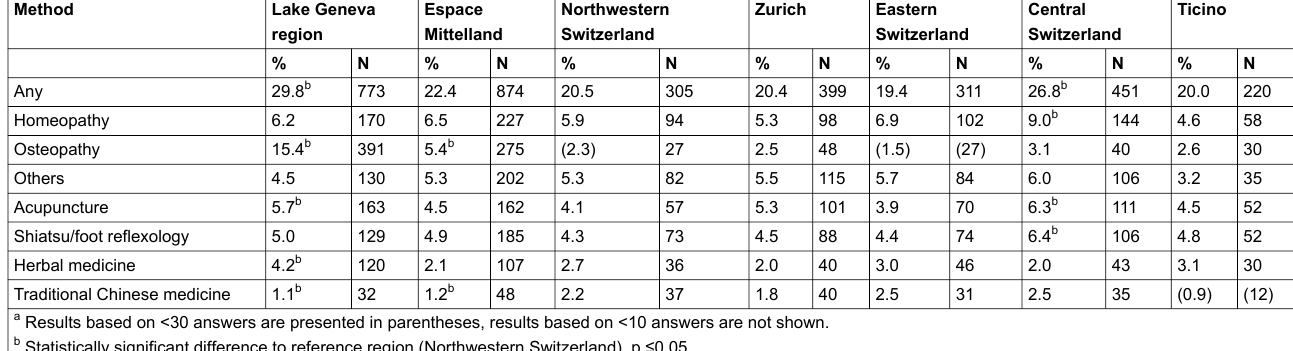
Table 1: Usage of various methods of CM (percentage and number of respondents [N]) in the last 12 months depending on area of living (Swiss Health Survey, Switzerland, 2007) a . Method